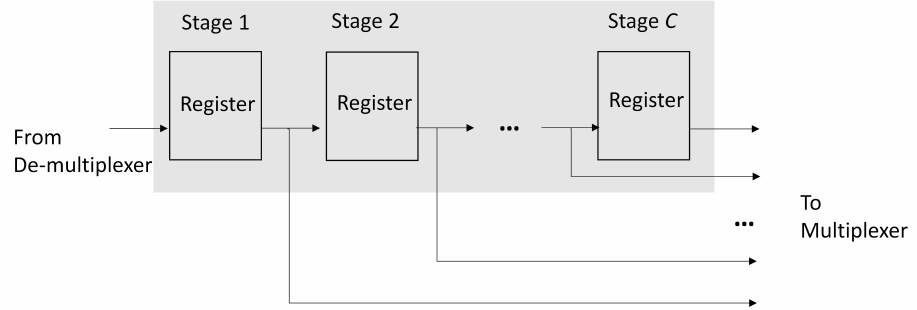
Figure 8. The architecture of positive response buffer and negative response buffer. Each buffer is a C -stage shift register supporting SIPO operations.